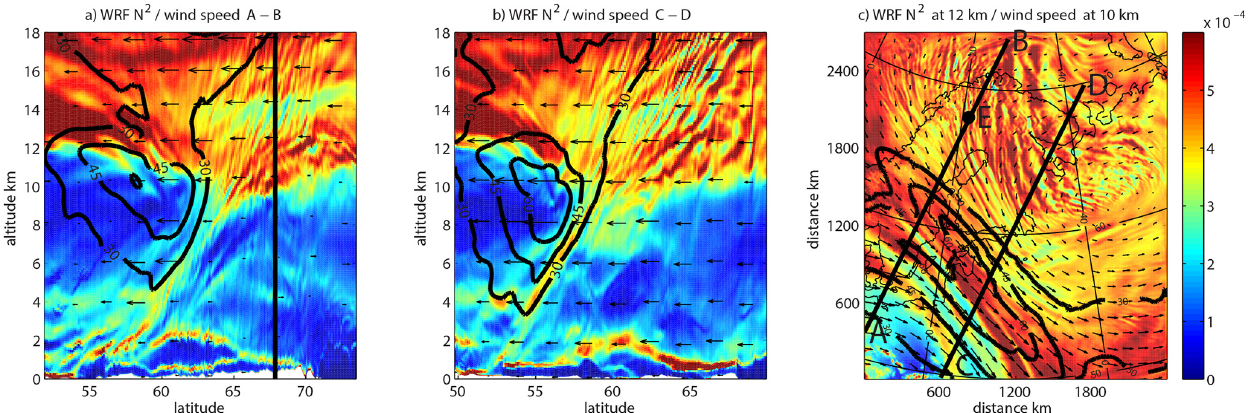
Figure 5. Results from the WRF model for 00:00UTC on 21 February 2007. (a) Vertical cross section along line A–B in Fig. 5c, vertical black line indicates the radar location. (b) Vertical cross section along line C–D in Fig. 5c. (c) Horizontal cross section for N 2 at the model level which is at 12km altitude at the radar site (marked by a black circle), and for wind at 10km. Colour scale shows N 2 (in s − 2 ). Black contours and arrows show wind speed and direction. In (a) and (b) the arrows show the wind component in the plane of the cross section.